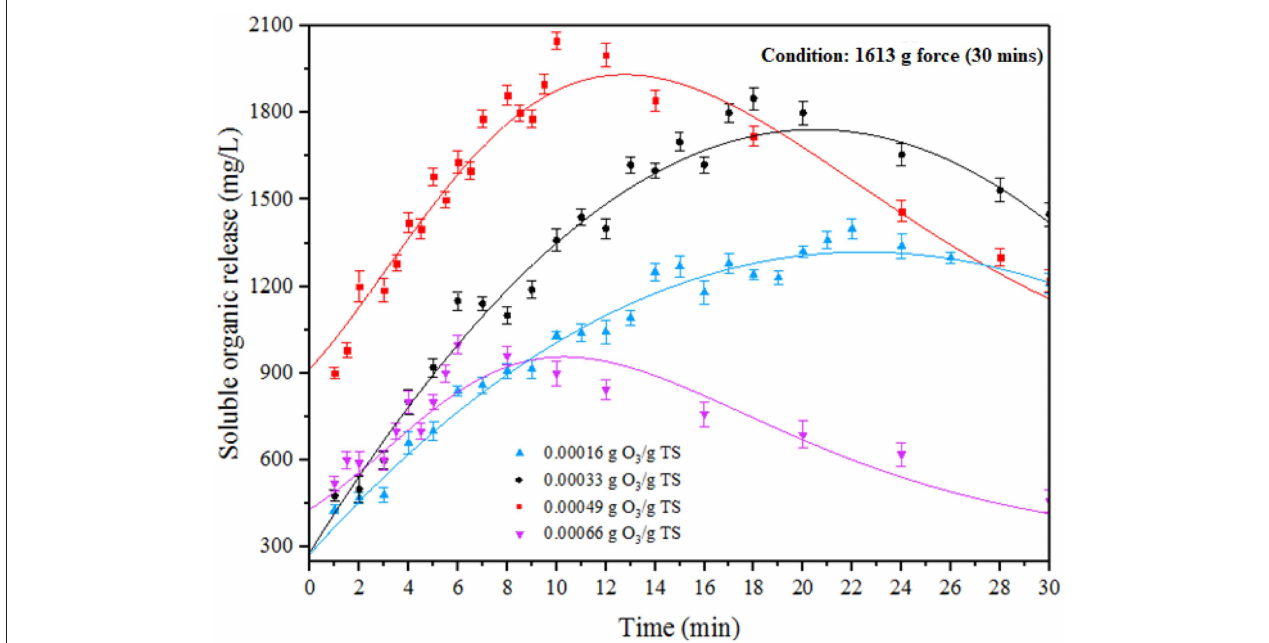
FIGURE 2 | Effect of ozone disperser pretreatment (ODP) on organic matter release.